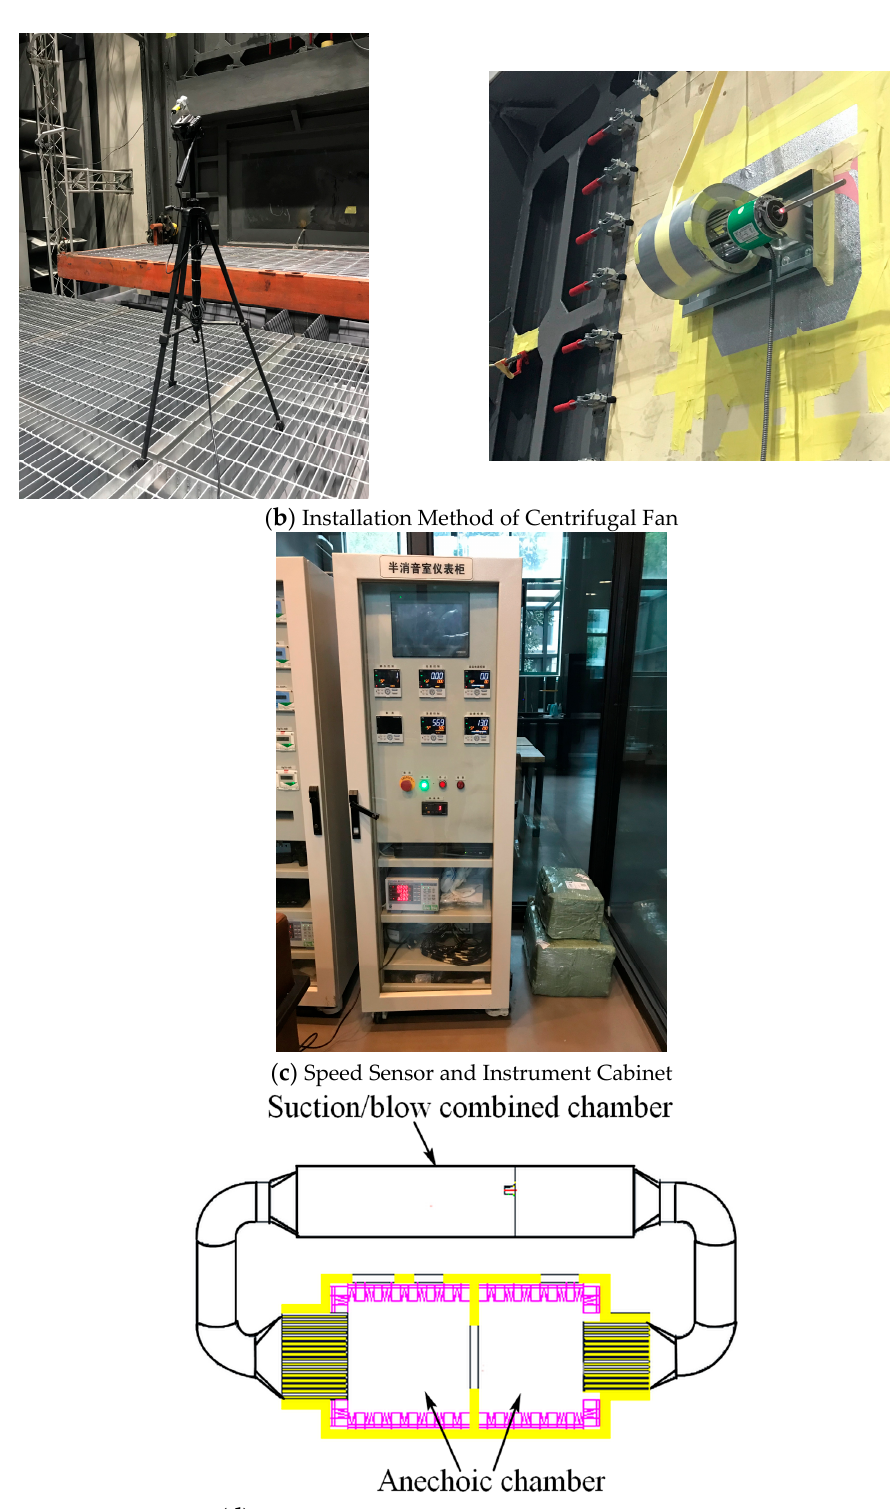
Figure 2. Laboratory test system .